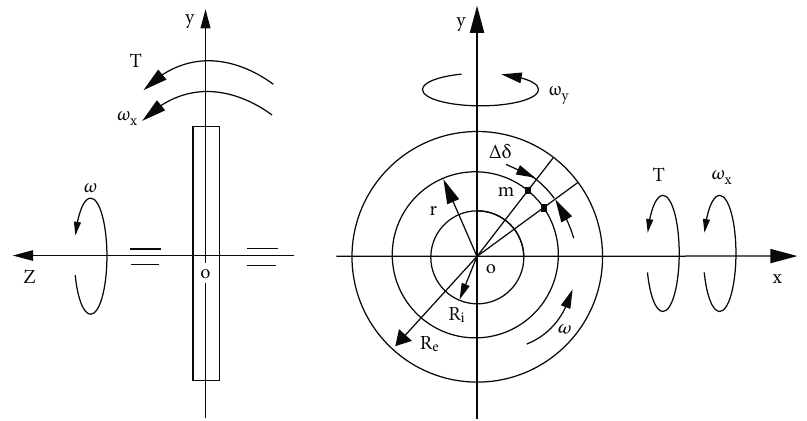
Figure 1: Schematic of the spinning